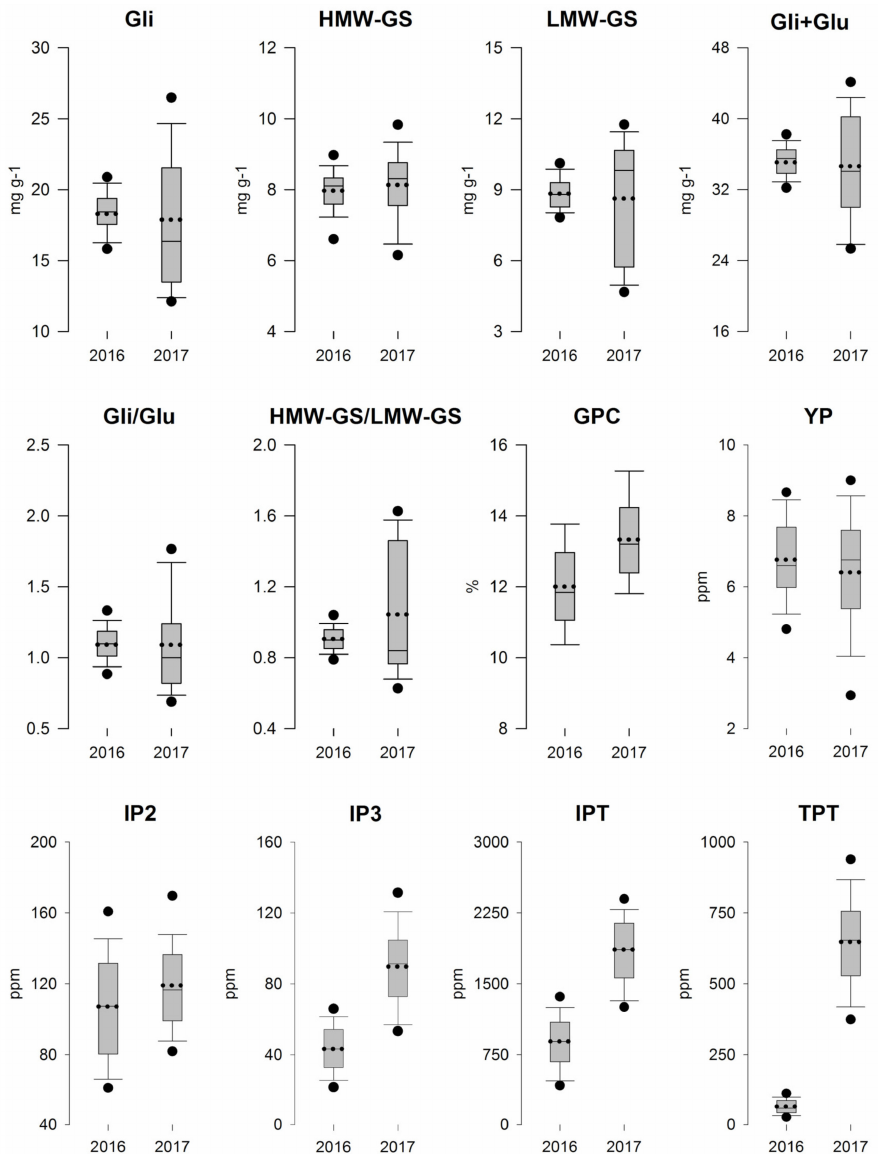
Figure 2. Box and whisker plots display variation in the two cropping seasons of gliadins (Gli; mg g − 1 flour), high and low molecular weight glutenins (either as fractions high-molecular-weight glutenin subunits (HMW-GS), low-molecular-weight glutenin subunits (LMW-GS), or total Glu; mg g − 1 flour), grain protein content (GPC; %), yellow pigment (YP; ppm), and peptides triggering the adaptive (IP2, IP3, IPT; ppm) and innate (TPT; ppm) immune response in celiac disease (CD) patients. Lower and upper dots indicate the 5th and 95th percentile, respectively, while the dotted line indicates the average